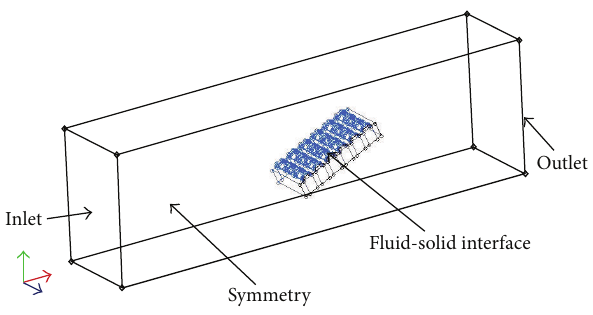
Figure 4: The computed field applied in the numerical simulation.